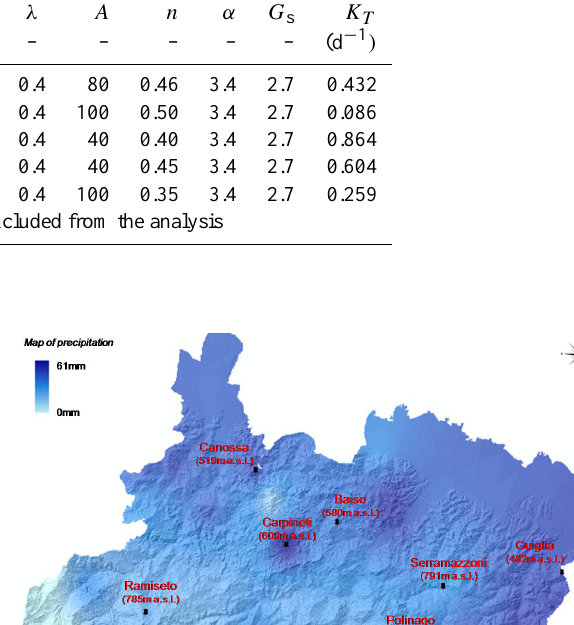
Table 2. Input parameters for the SLIP analysis on one year period. Soil